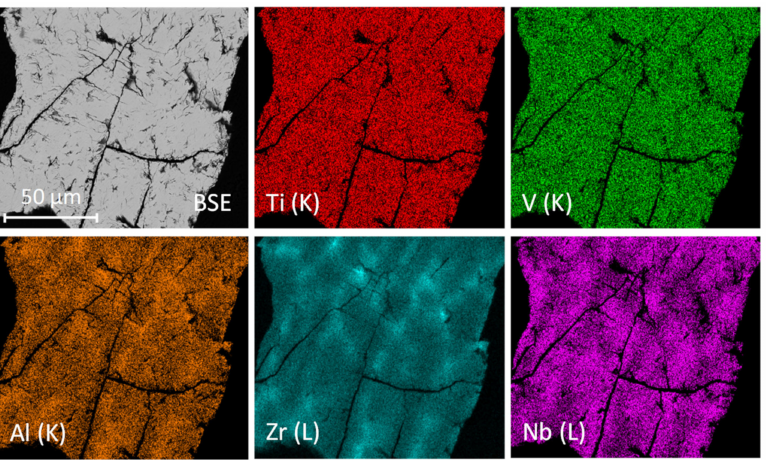
Figure 4. Chemical mapping, scanning electron microscopy and energy-dispersive X-ray spec-